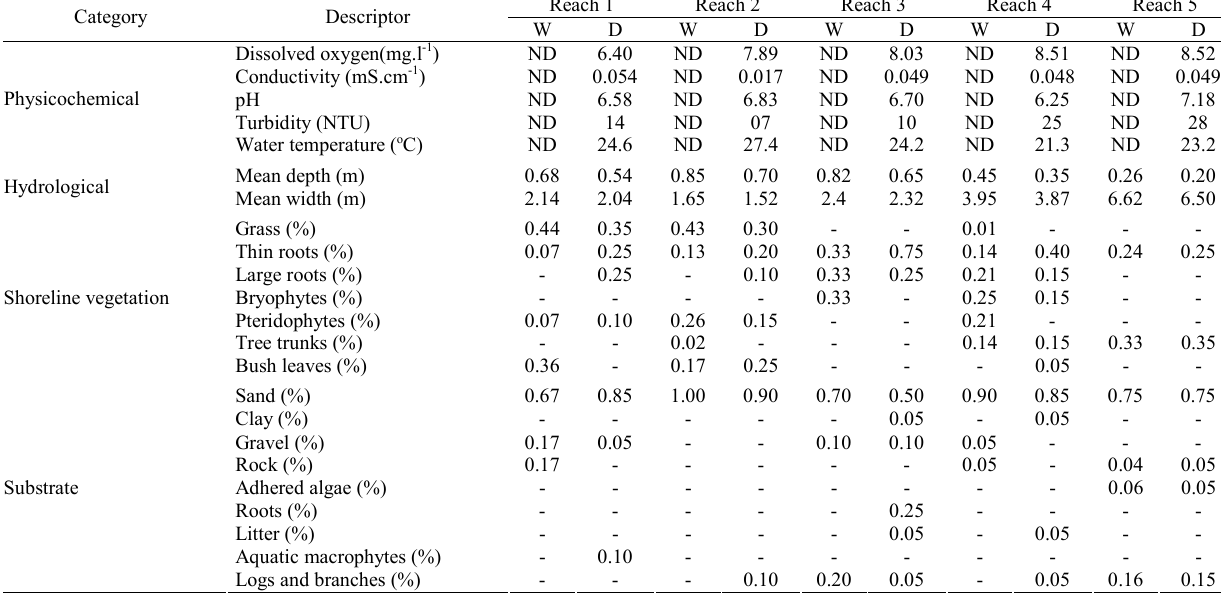
Table 2. Values of physicochemical (absolute) and physical habitat (proportion) descriptors of reaches (R1-R5) of the Correntes stream in the wet (W) and dry period (D), central west Brazil. ND = no data